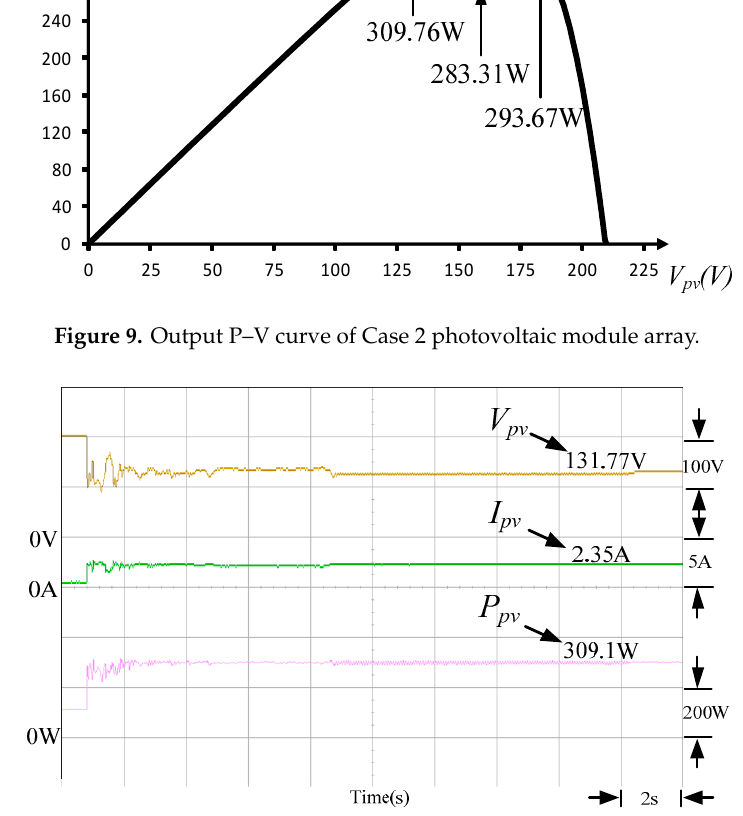
Figure 10. Case 2 measured results of maximum power point tracking by using TLBO algorithm. (3) Case 3 (10 panels in each of 4 parallel string arrays): [1 panel, 30% shaded + 9 panels, 0%